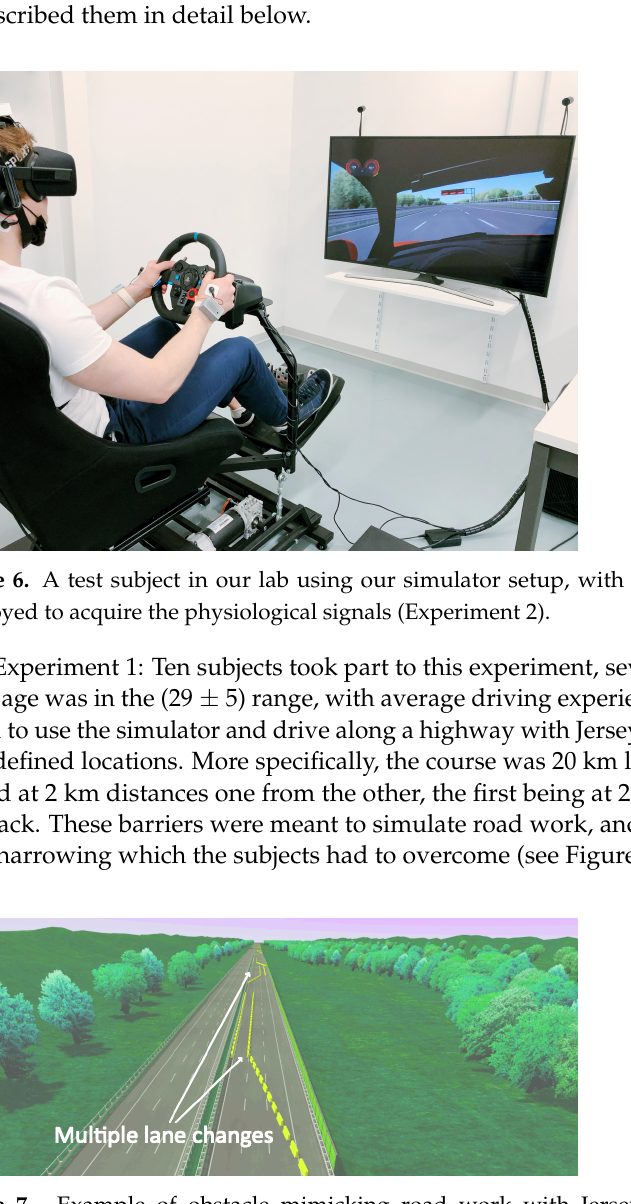
Figure 7. Example of obstacle mimicking road work with Jersey barriers to force multiple lane